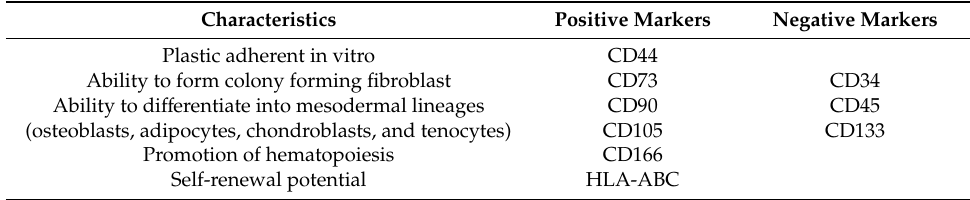
Table 1. Standard criteria of mesenchymal stem cells defined by the Mesenchymal and Tissue Stem Cell Committee of the International Society for Cellular Therapy